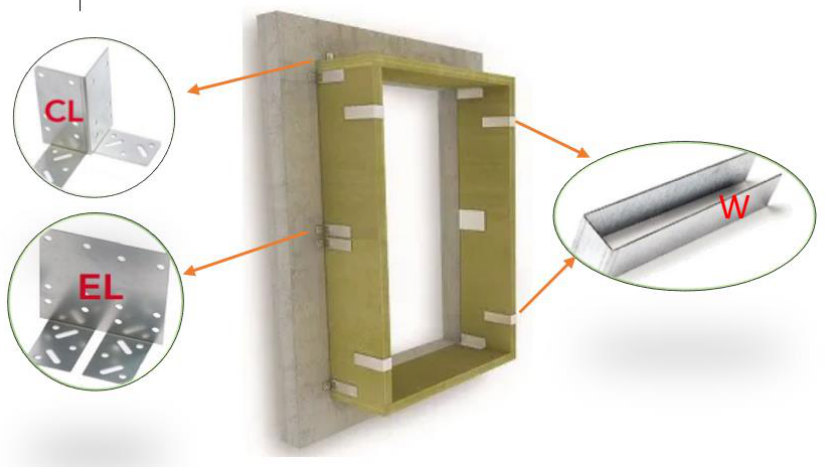
Figure 4. System of window installation in the insulation layer using the stone wool boards (SWB) REDAir TM LINK [33].